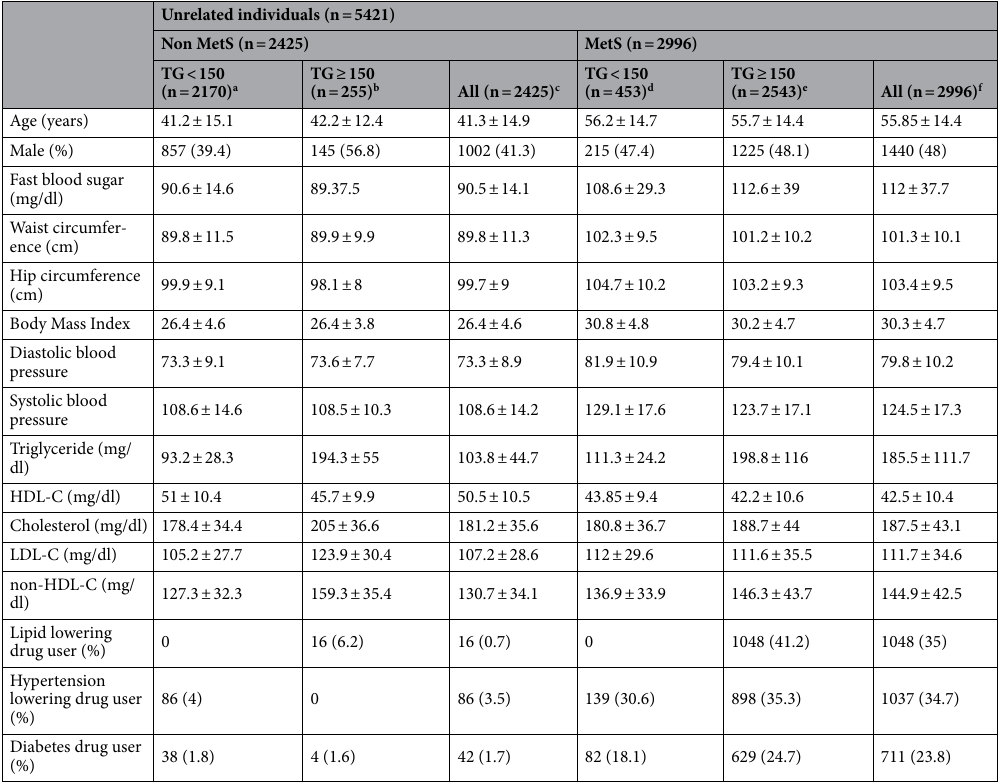
Table 1. Summary of demographic and clinical characteristics of study individuals. Values expressed as mean ± SD or number (%). LDL-C low-density lipoprotein cholesterol, HDL-C high-density lipoprotein cholesterol. p-values of t-student or chi-square test between the case and control groups in both models were significant (p < 0.001). a HTg-MetS model control group. b Excluded from HTg-MetS model. c MetS model control group. d Excluded from HTg-MetS model. e HTg-MetS model control group. f MetS model case